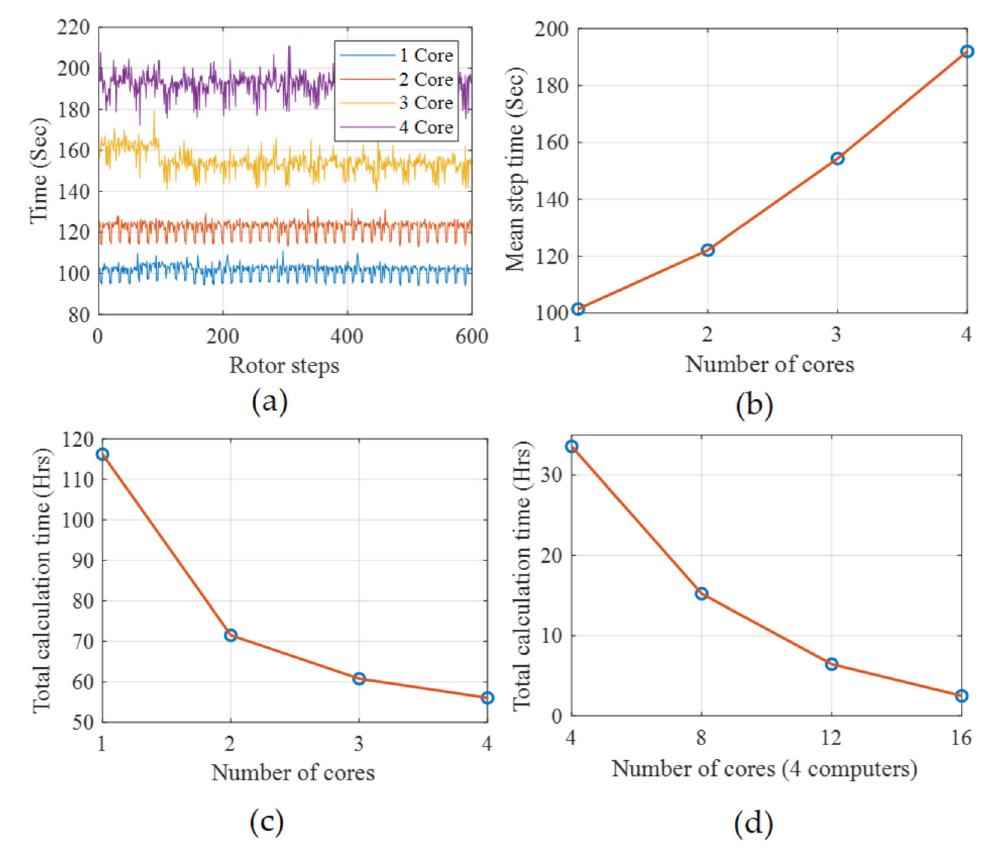
Figure 10. The simulation time, ( a ) per step with di ff erent number of single computer workers (cores) in parallel, ( b ) the mean per-step time with di ff erent number of cores of a single computer working in parallel, ( c ) overall time on one computer with di ff erent cores engaged in parallel, ( d ) overall time with di ff erent number of computers making a cluster with distributed cores in